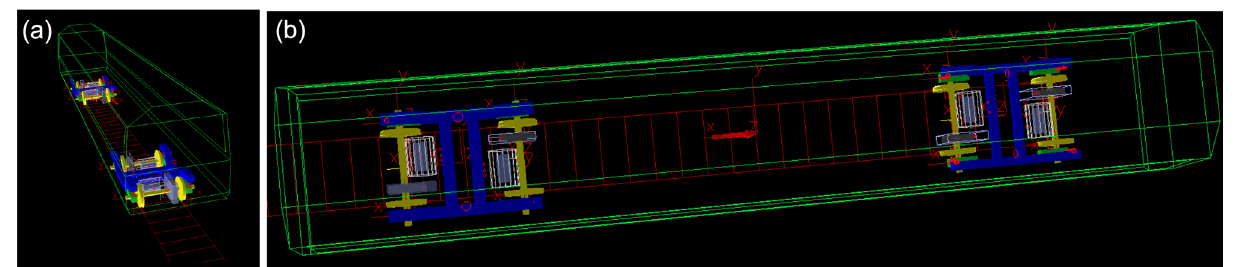
Figure 3. Block diagram of direct torque control for traction motor.